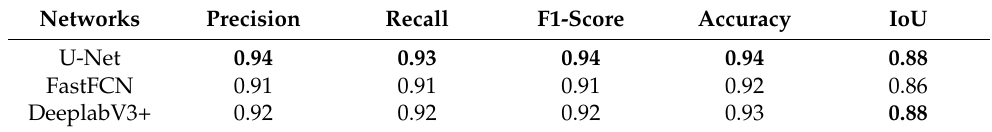
Table 7. The accuracy evaluation indicators of different three kinds of networks. Networks Precision